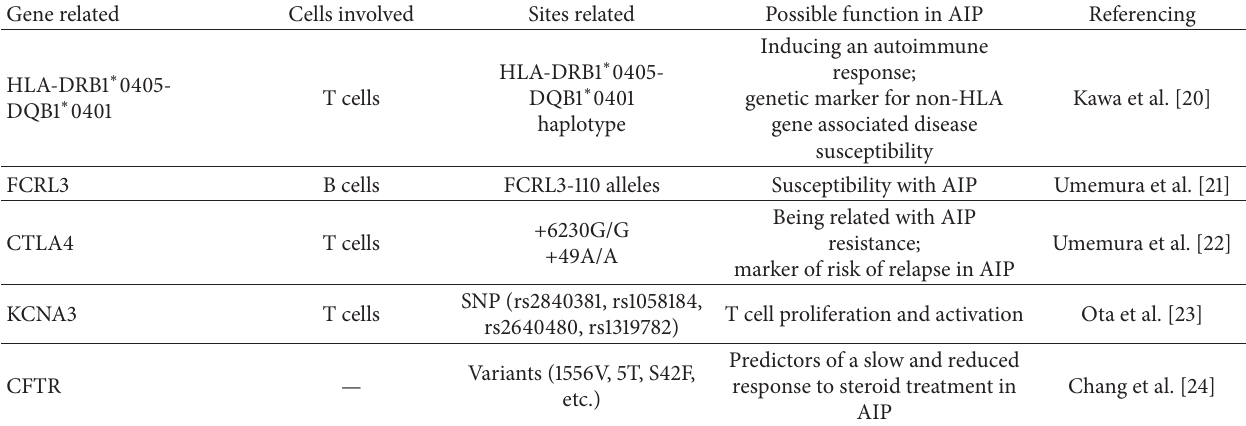
Table 2: Genetic factors in the pathogenesis of AIP.